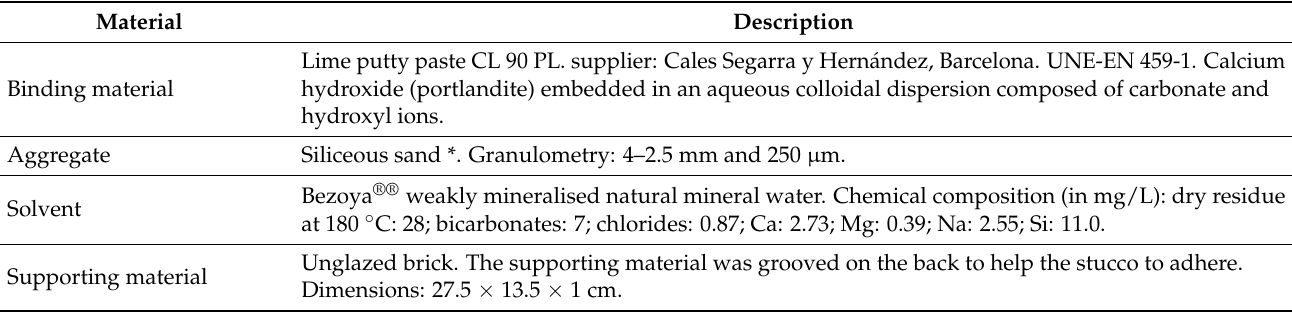
Table 1. Technical features of materials used to make the test